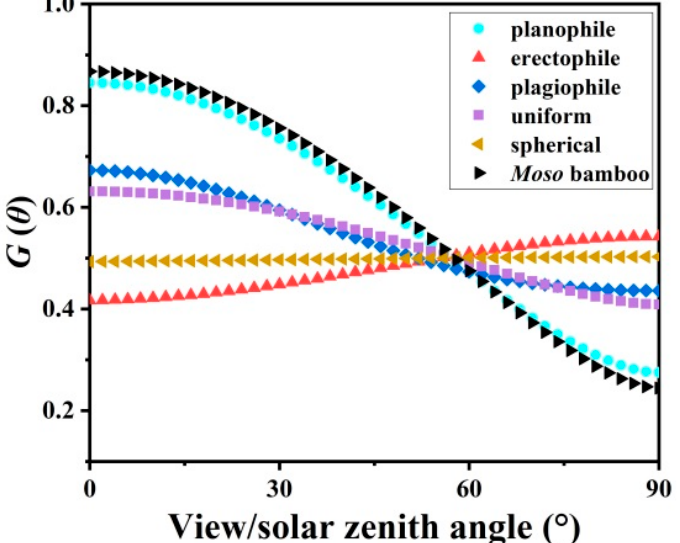
Figure 7. Leaf projection functions G ( θ ) against view/solar zenith angle θ . The planophile , erectophile , plagiophile , uniform, and spherical cases are drawn for comparison based on de Wit [63].